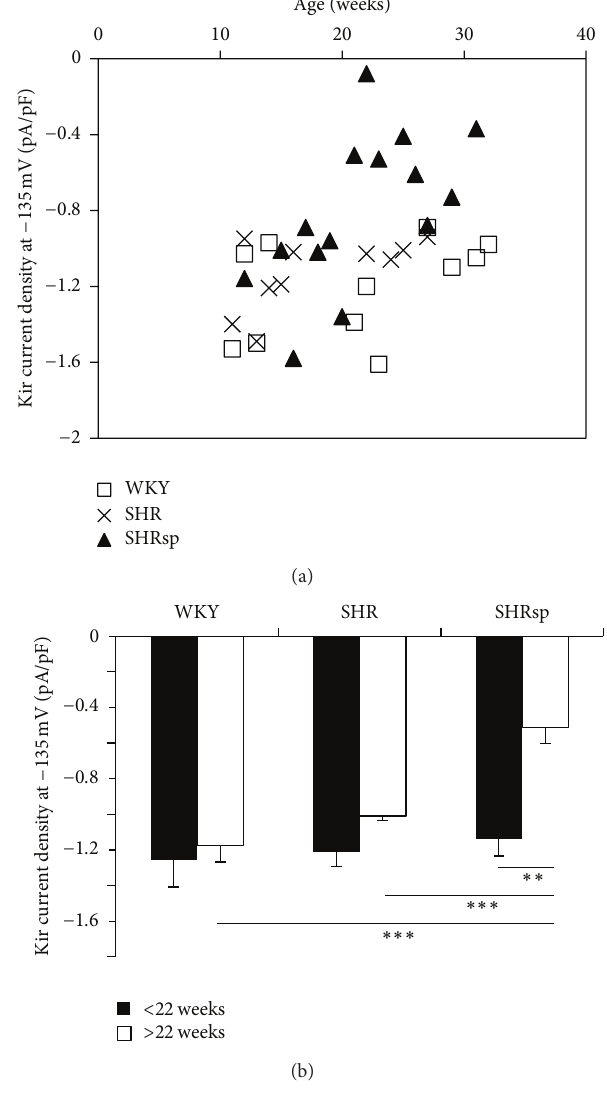
Figure 2: (a) Kir density measured at –135mV on SMC originated from WKY ( 𝑛 = 11 ), SHR ( 𝑛 = 10 ), and SHRsp ( 𝑛 = 15 ) rats at different ages. (b) Histogram of Kir densities measured at –135mV for WKY, SHR, and SHRsp for the period 12–22 weeks and the period 22–32 weeks. Values are mean ± sem, ∗∗∗ 𝑃 < 0.000 , ∗∗ 𝑃 < 0.005 .